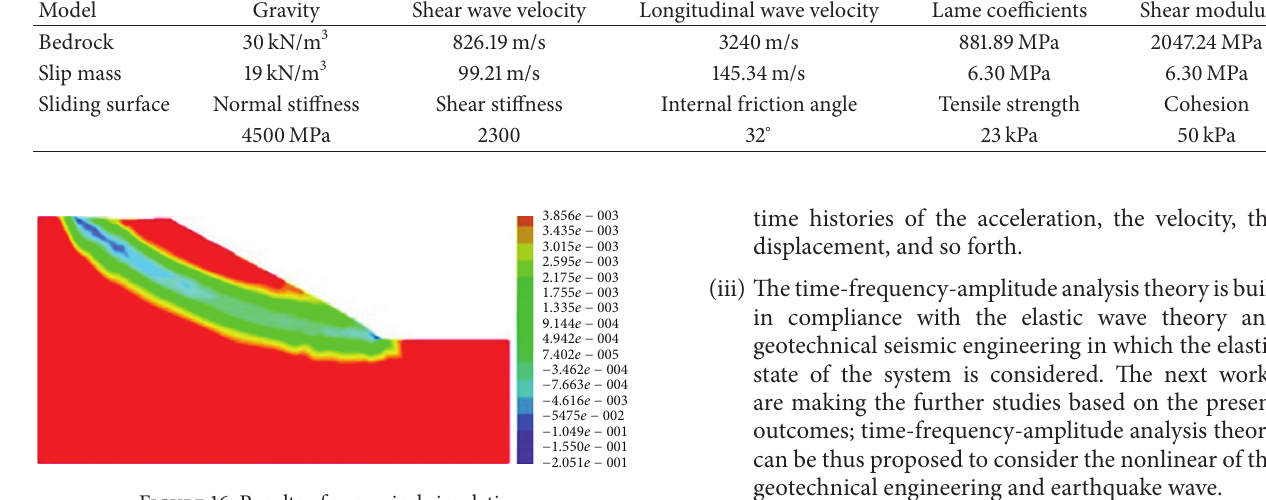
Figure 16: Results of numerical